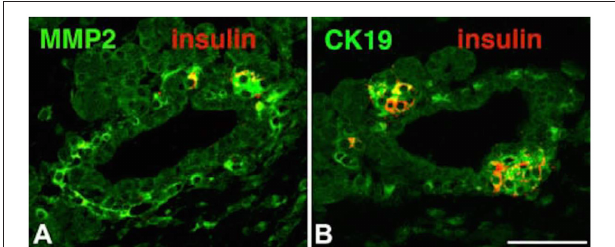
FIGURE 2 | Immunohistochemistry of islet markers for morphogenesis including; matrix metalloproteinase-2 (MMP-2), cytokeratin 19 (CK19) and insulin. MMP-2 and Ck19 appeared in A and B sections (green). Insulin positive cells (Red) budding from the ducts appeared in section close to ducts (B) . Adapted from Aye et al. (2010). Copyright © 2010 by SAGE Publications. Reprinted with permission from SAGE